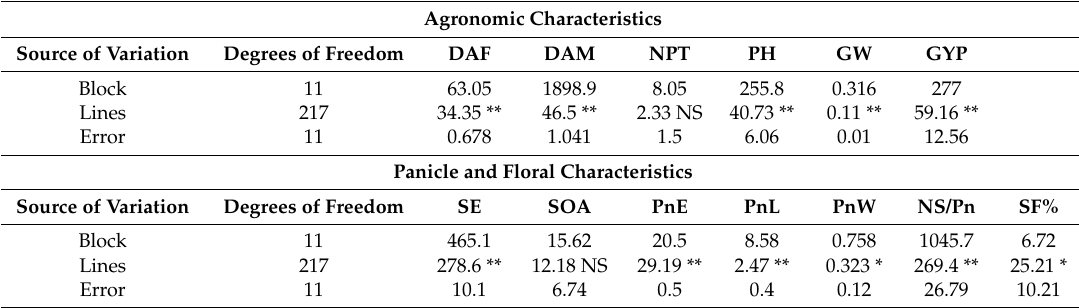
Table 1. Analysis of variance of maintainer lines for agronomic and floral traits.